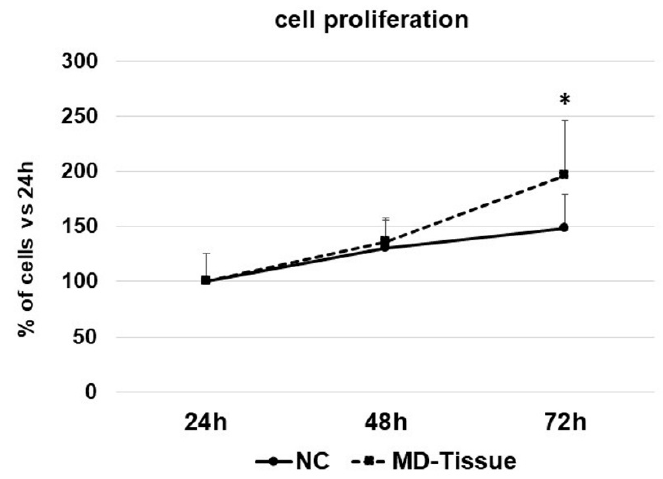
Figure 1. Growth curves of tenocytes grown without (NC) or on MD-Tissue at the indicated time points. Data are expressed as percentages vs. the time point T24 and are mean + SD. * p < 0.05 vs. 72 h NC.